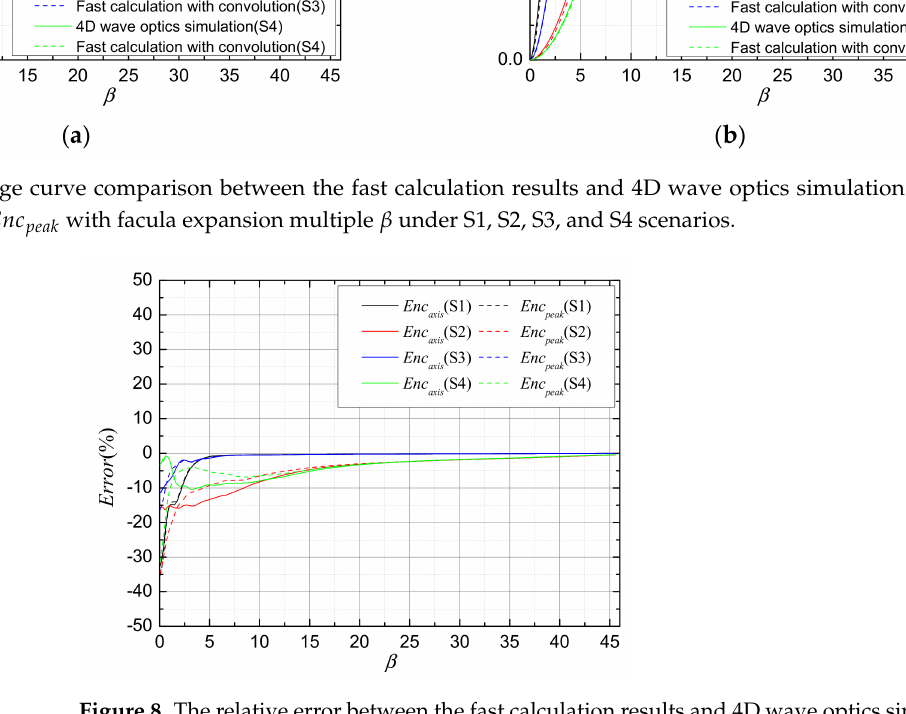
Figure 8. The relative error between the fast calculation results and 4D wave optics simulation results for Enc axis and Enc peak under S1, S2, S3, and S4